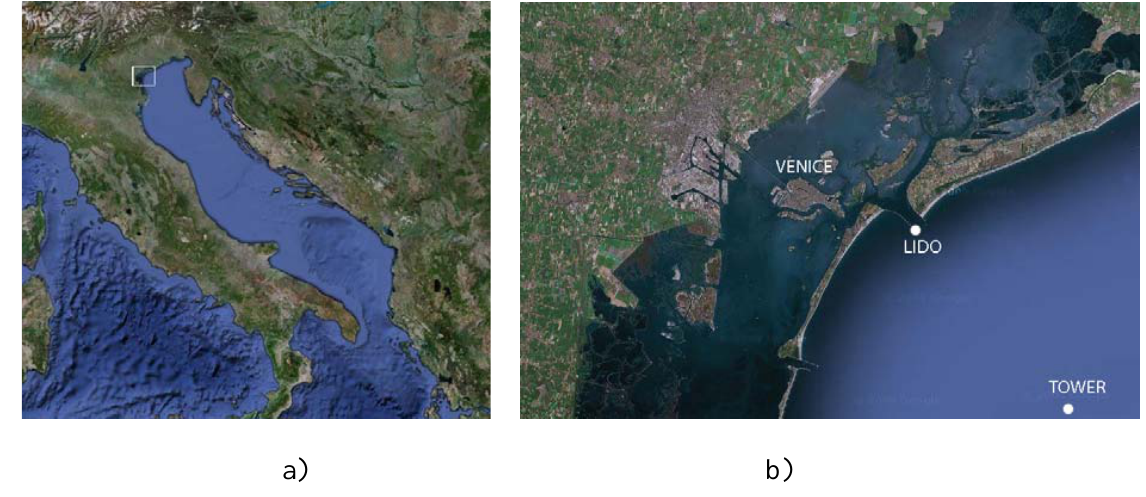
Fig. 2. (a) The Italian peninsula and the Adriatic Sea to its right. The enclosed area is enlarged in (b) , where the dots show the position of the ISMAR oceanographic tower and of the tide gauge at the Lido exit of the Venice lagoon.